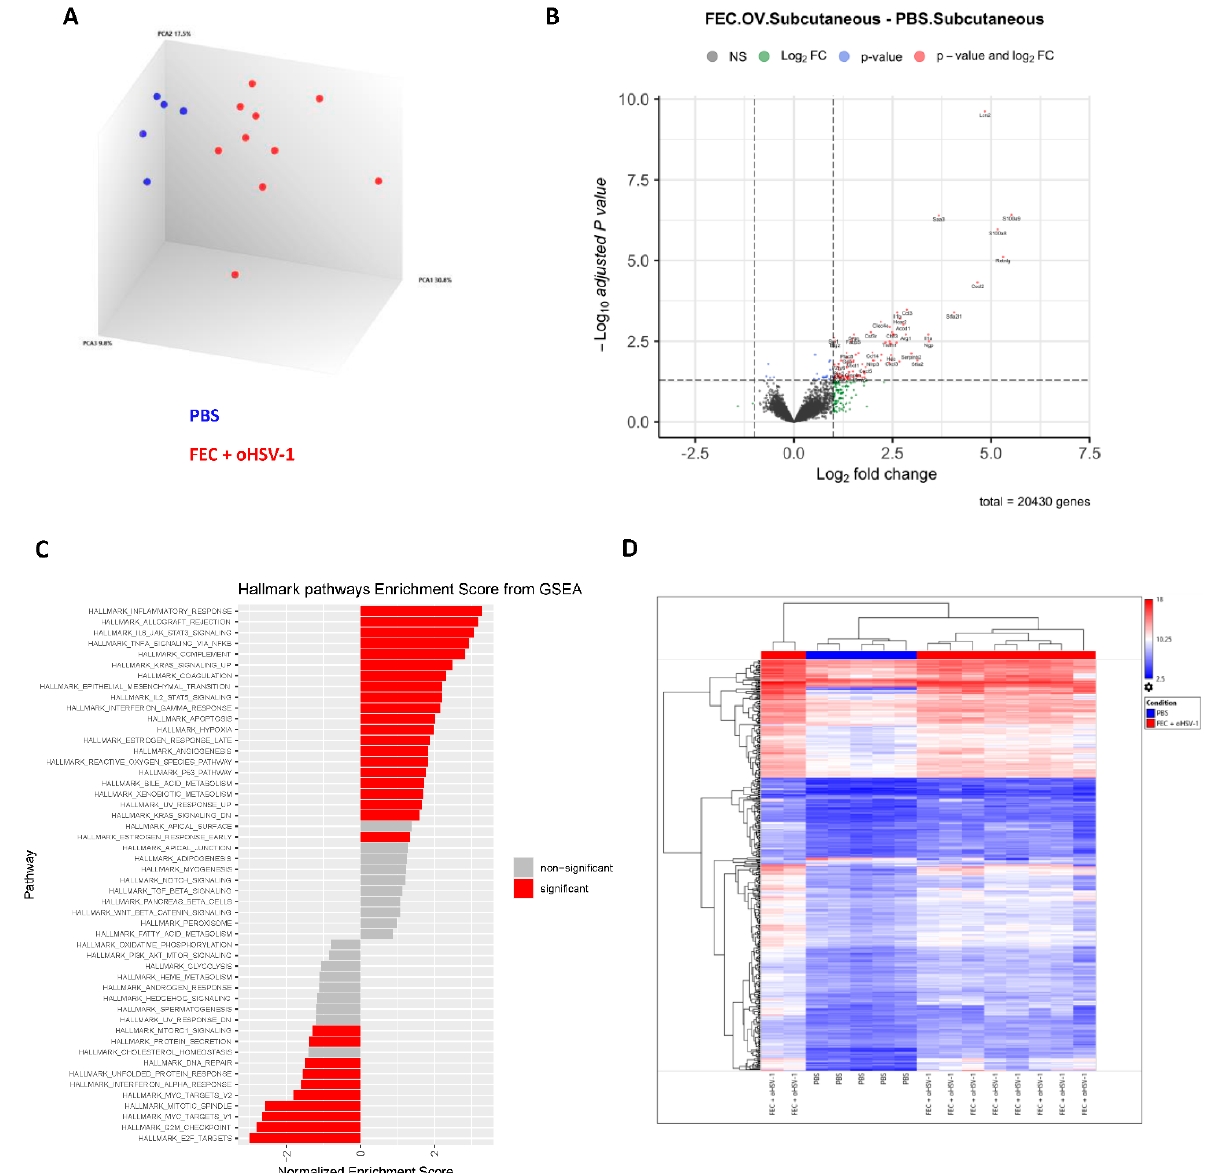
Figure 2. FEC + oHSV-1 therapy upregulates many immune pathways and processes associated with myeloid cells in subcutaneous E0771 tumors; C57/Bl6 mice bearing E0771 subcutaneous tumors were treated with either PBS or FEC + oHSV-1. Tumors were harvested on day 5, and RNA was extracted from whole tumor digests and sent for Clariom analysis. ( A ) A 3-D cluster plot showing the RNA expression correlations between mice treated with PBS (blue; n = 5) and FEC + oHSV-1 (red; n = 10). ( B ) Volcano plot showing differentially expressed genes between tumors treated with FEC + oHSV-1 and PBS. ( C ) Heat map showing the normalized expression values of genes across all samples. ( D ) Bar plot illustrating the results of hallmark pathway enrichment analysis performed on samples from mice treated with FEC + oHSV-1 compared to those treated with PBS alone.